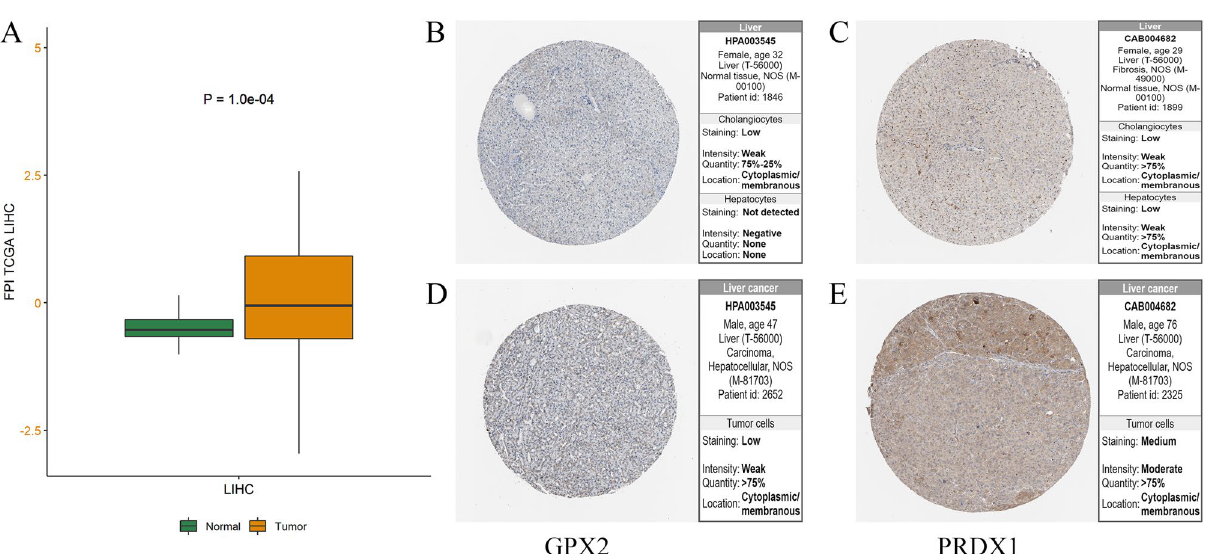
Figure 8. The relations between FPI and tissues and different protein expressions in four genes were verified in human tissue samples. ( A ) The different FPIs between tumor and normal samples among HCC. ( B–E ) Human Protein Atlas (HPA) immunohistochemistry using anti-GPX2 and anti-PRDX1 antibodies. Normal liver ( B,C ) vs. tumor tissues ( D,E